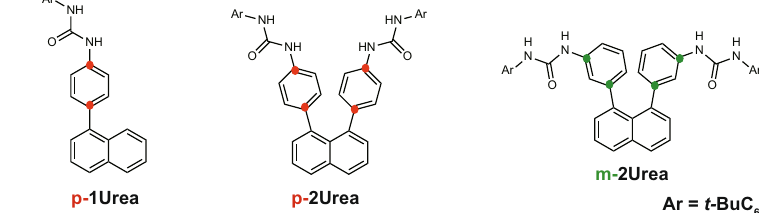
Fig. 1 Schematic representation of design strategy for ionic hydrogen-bonded complexes (IHBC) with aggregation-induced emission enhancement (AIEE). a Schematic illustration of the addition of electron-donating (D) and/or electron-withdrawing (A) groups to fl uorophores to synthesise typical AIEE fl uorophores. b Design strategy for IHBC with viscosity-sensitive fl uorescence and AIEE (this work). c Urea as hydrogen-bond donating group and acetate as hydrogen-bond acceptor. d Chemical structures of model molecules: p -1Urea , p -2Urea , and m -2Urea